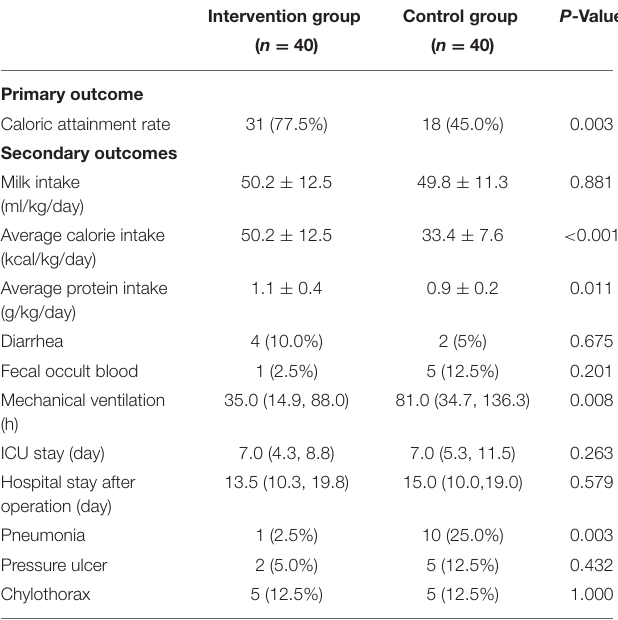
TABLE 2 | Feeding related outcomes and clinical